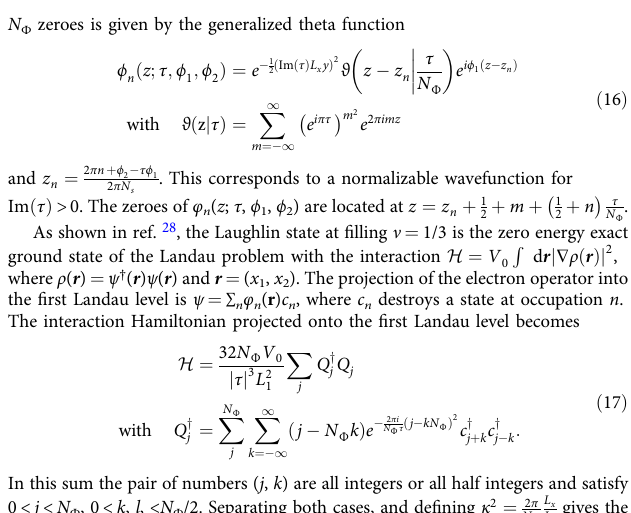
Fig. 5 Adiabatic evolution of the system. a The purity of the fi nal state for different ramp velocities Δ in a system with L = 9 sites. A slower variation in the adiabatic protocol leads to a higher purity. b The system ends up in the DDS regardless of the ramp velocity. Different Δ ’ s control how much of the Hilbert space is explored. c The purity of the fi nal state can be manipulated via the ramp